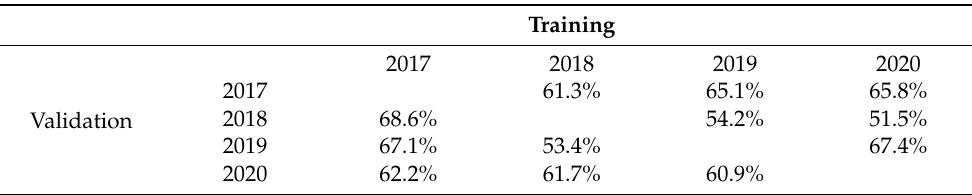
Table 4. Accuracy metrics derived from training an RF classifier in a year and applying on the other